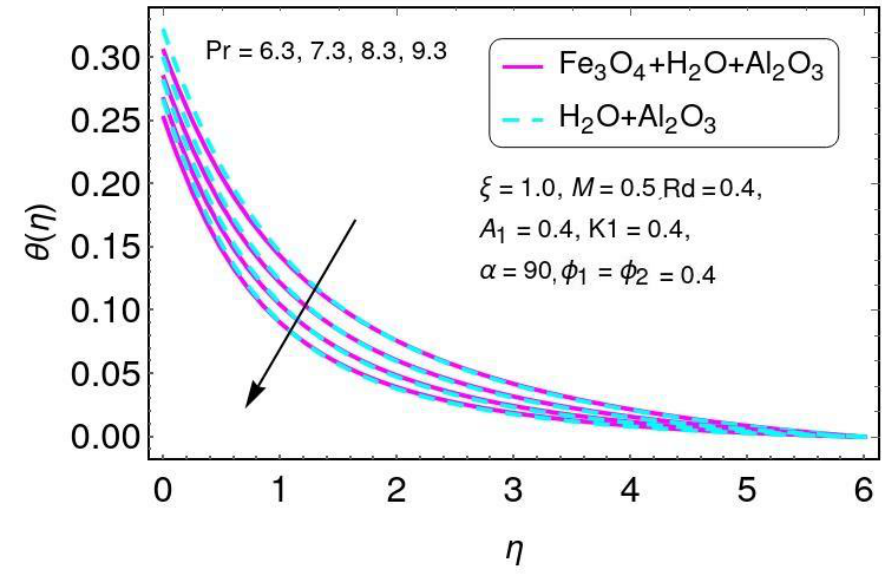
Figure 6. The gradient of ( η ) for Pr .